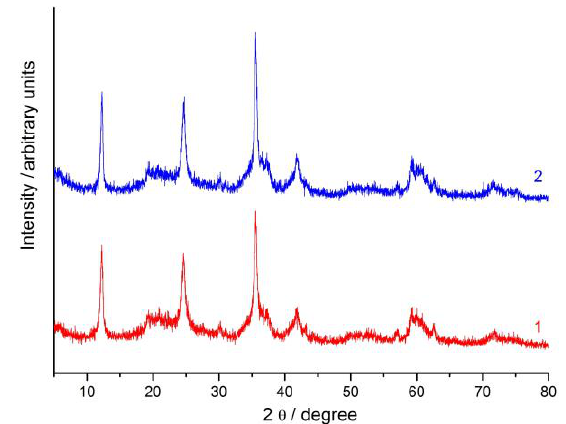
Figure 11. The X-ray diffraction patterns of 1 : antigorite milled in moderate conditions for 600 s in air, 2 : alkali-activated binder prepared using antigorite milled for 600 s in moderate conditions in air and liquid glass with a modulus of 2.25 (the amount of liquid glass added corresponded to 3% Na 2 O, curing time in dry conditions was 28 days).